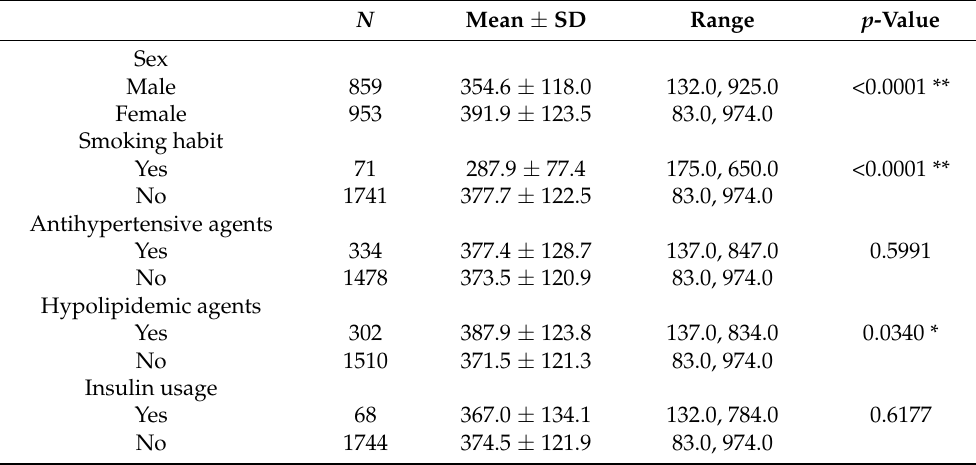
Table 5. Associations among skin carotenoid levels and various categorical